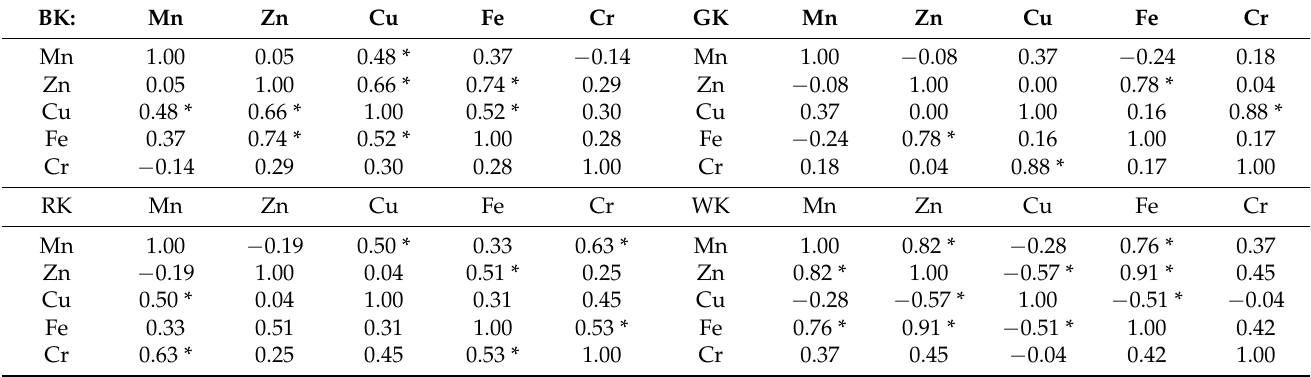
Table 6. Spearman’s rank correlation between micronutrients for different types of Kombucha.